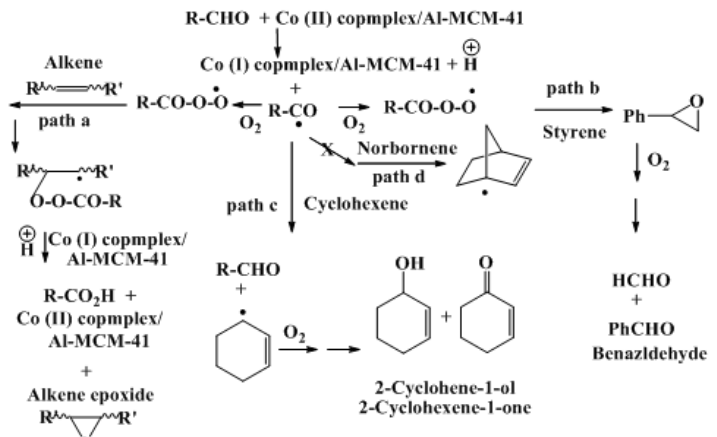
Scheme 1. Mechanism evoked for the oxidation reaction of